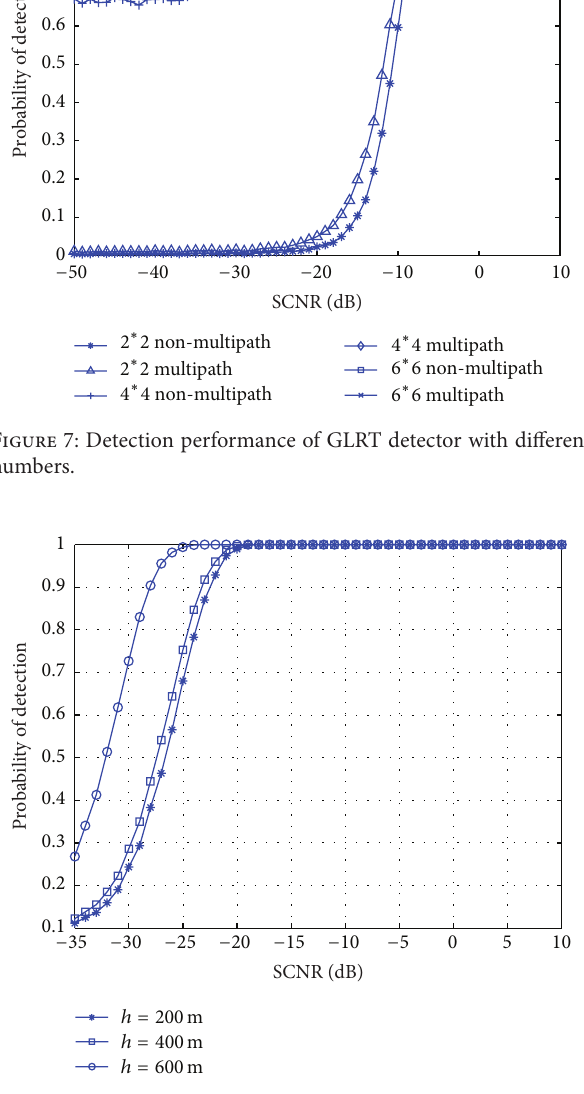
Figure 8: GLRT-LQ detector detection performance varies with the height of